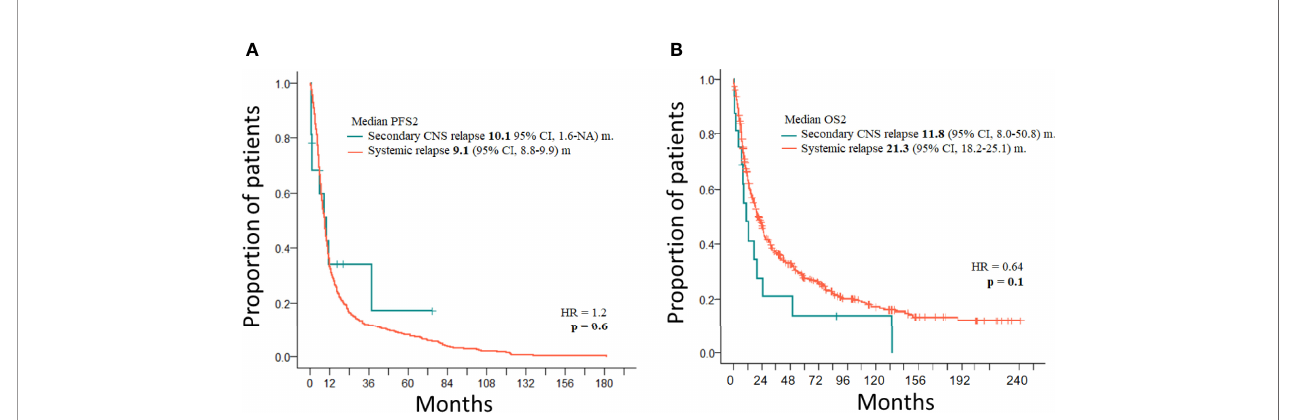
FIGURE 3 | (A) PFS2 of PTCL with secondary CNS disease ( n = 16) and with systemic relapse ( n = 493). (B) OS2 of PTCL with secondary CNS disease ( n = 16) and with systemic relapse ( n =